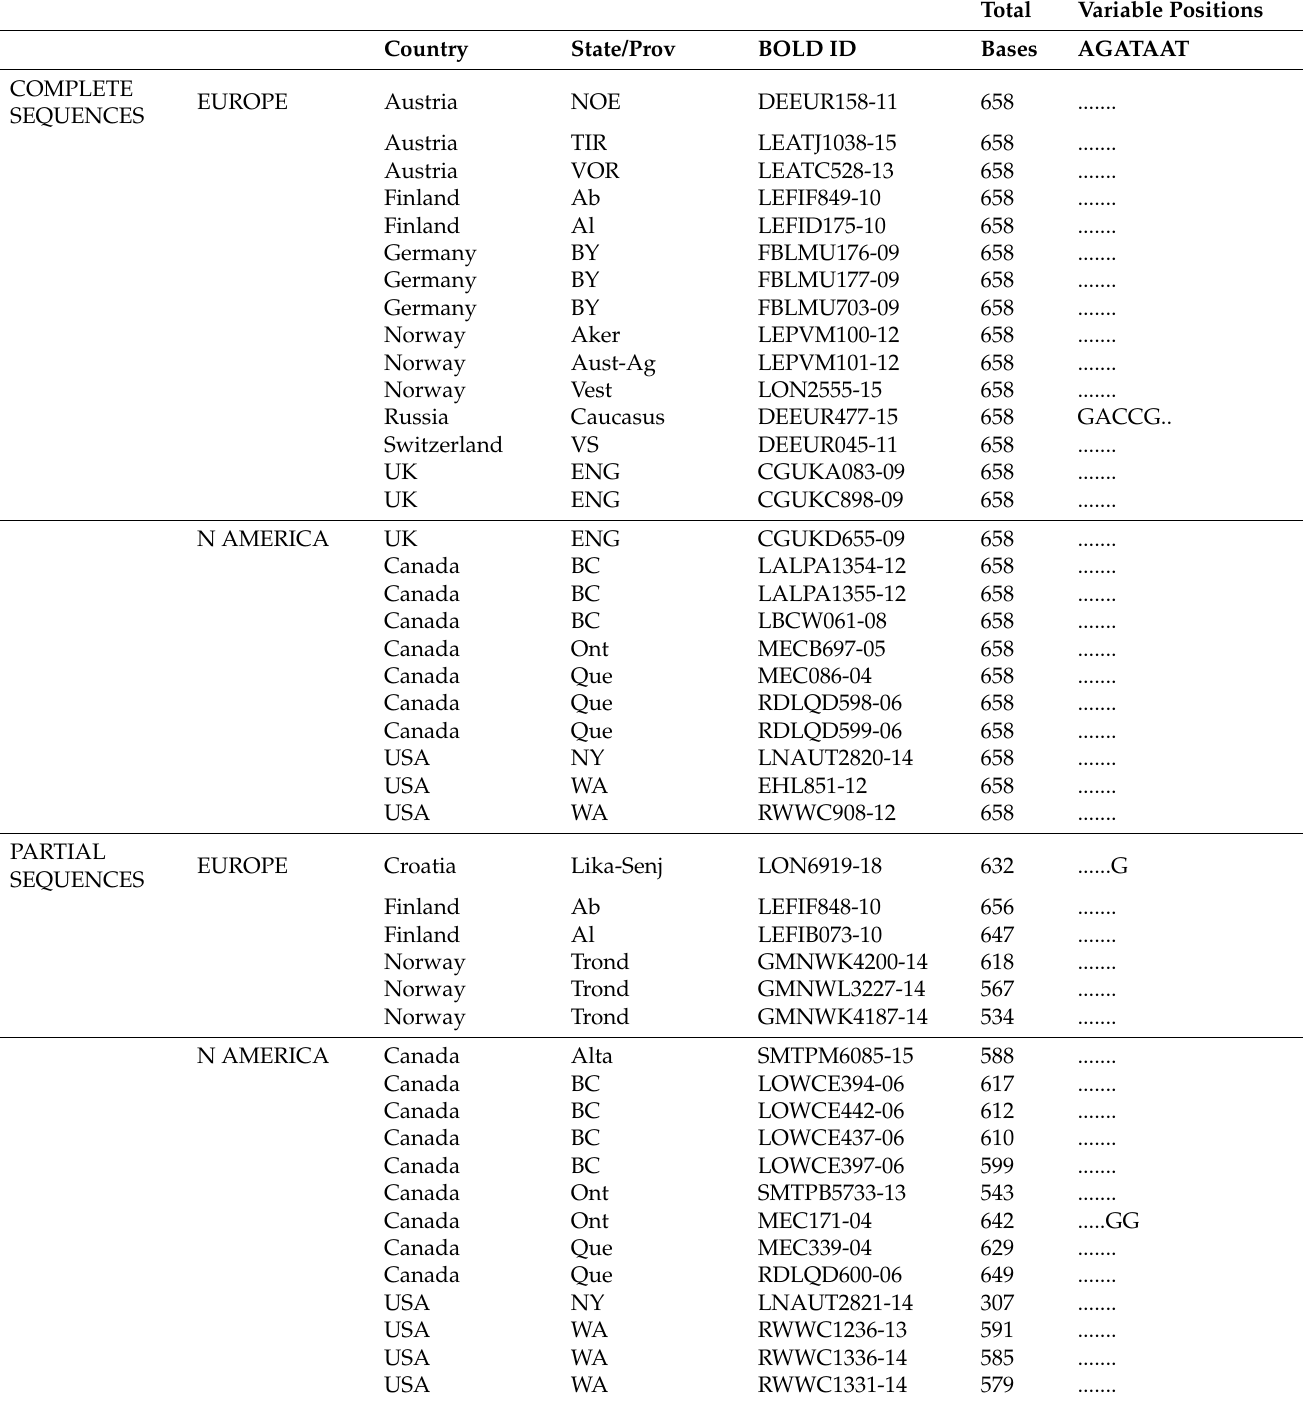
Table 2. Sites and sequence variation in Depressaria radiella . Variable alignment positions are 136, 302, 337, 578, 508, 592, 628, respectively. Total Variable Positions Country State/Prov BOLD ID Bases